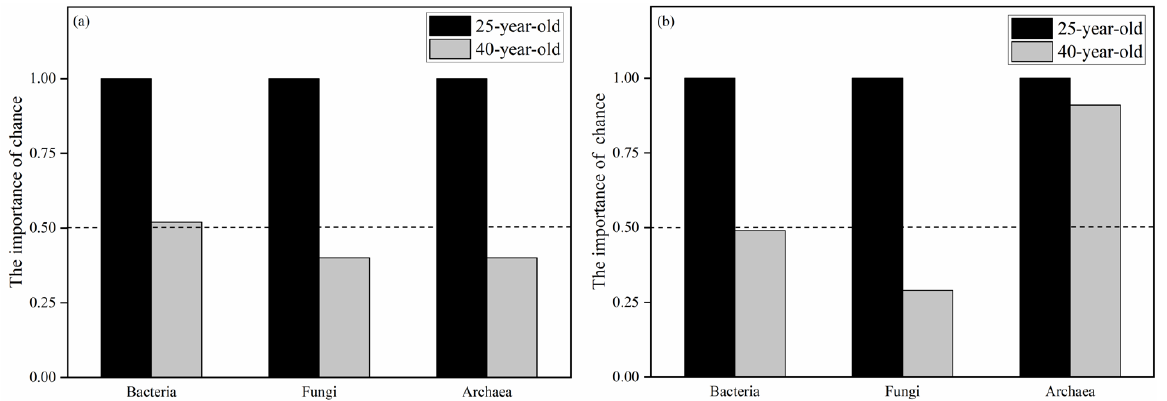
relationship were shown in bold ( p < 0.05).